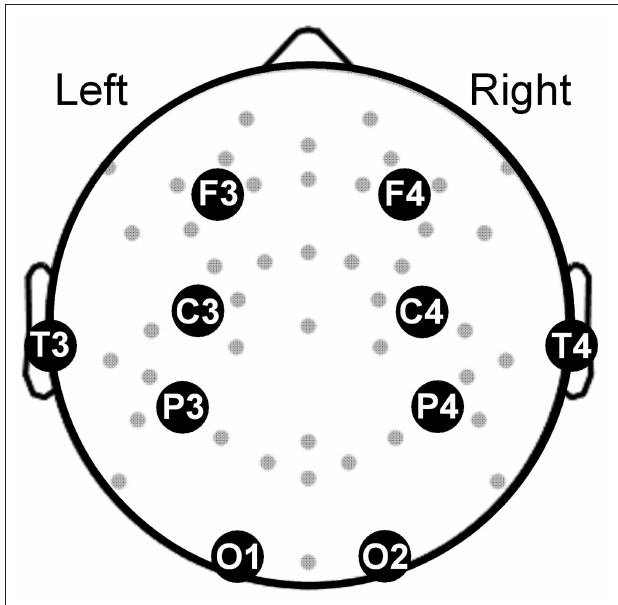
FIGURE 1 | Topographical map showing the electroencephalography channels (gray dots) covering the brain. Large filled circles along with abbreviated names mark the locations of the 10 channels used in our analysis. F3 and F4: frontal channels; C3 and C4: central channels; T3 and T4: temporal channels, P3 and P4: parietal channels; O1 and O2: occipital